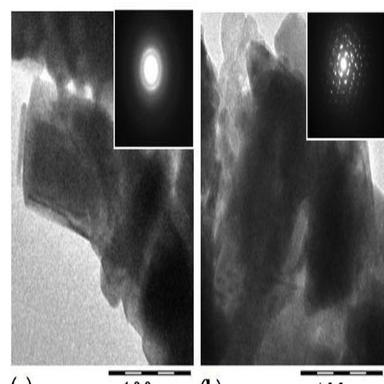
TEM images of the unexposed and exposed samples of STS ChGA: (a) 0 kGy, (b) 4 kGy, (c) 8 kGy, (d) 12 kGy.